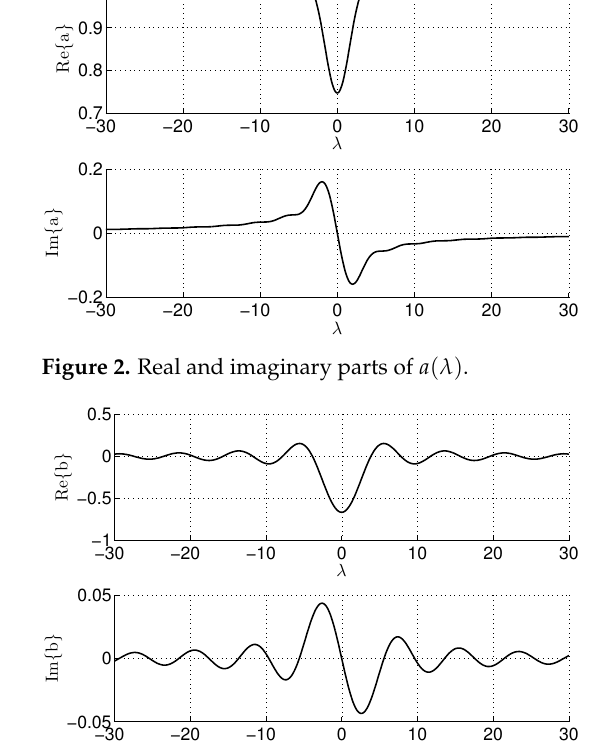
Figure 3. Real and imaginary parts of b ( λ )